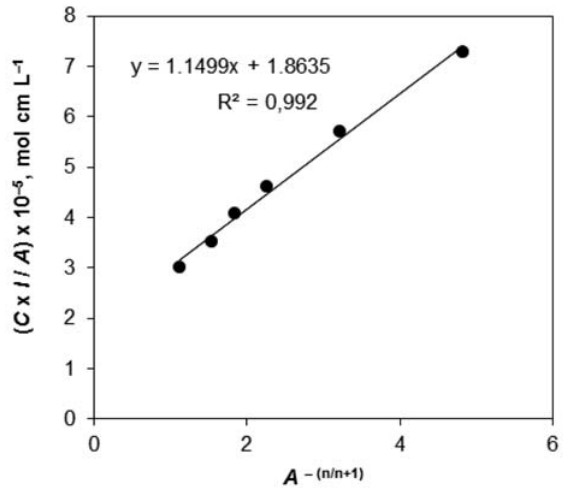
Figure 5. Dependency of ( C . l / A ) on A –n/(n+1) (method of Ko- mar–Tolmachev).